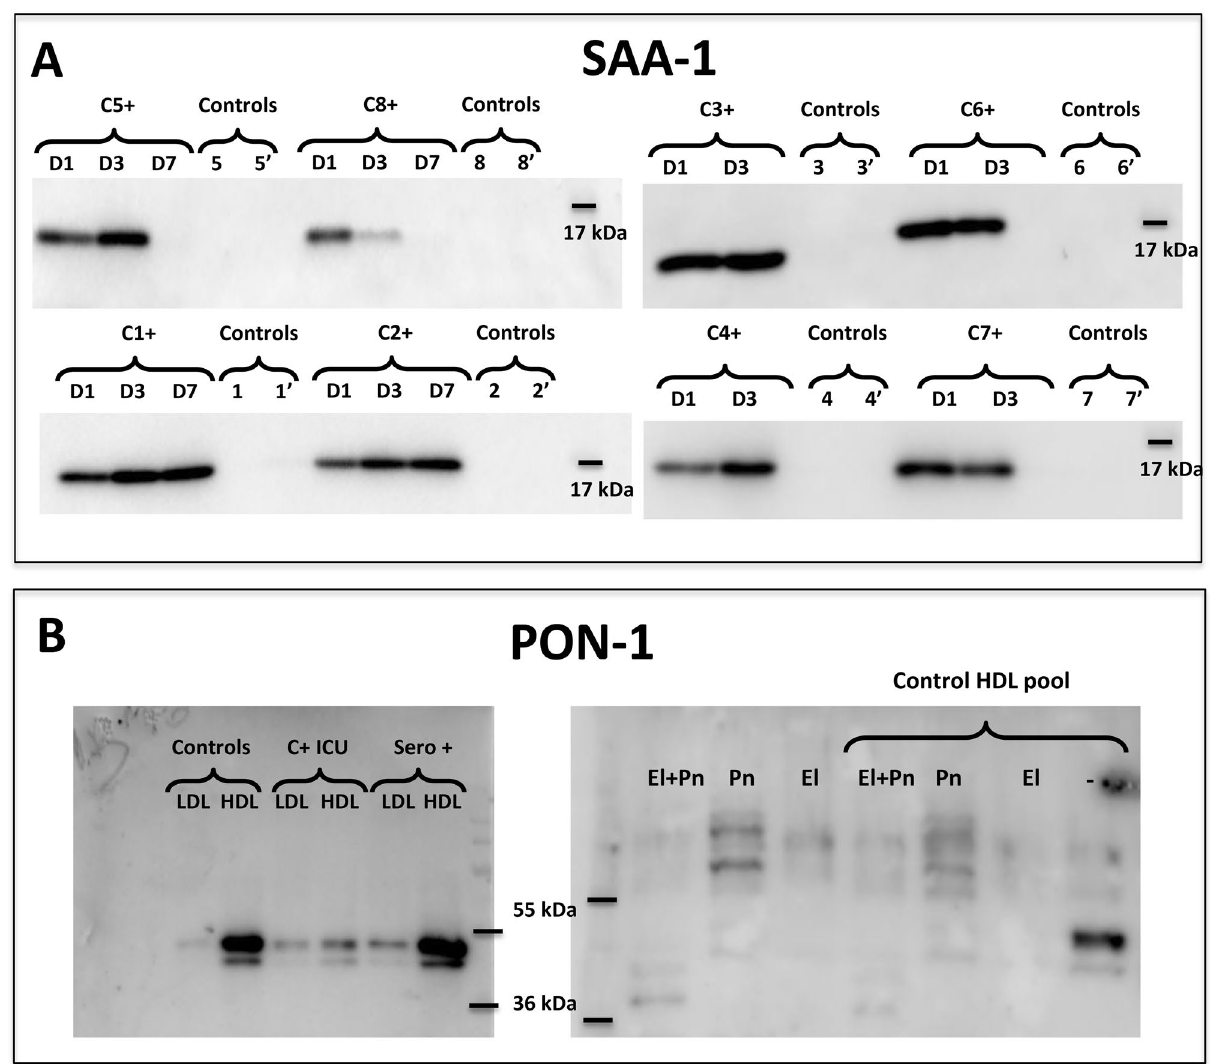
Figure 3. Western blot analysis for detection of SAA and PON-1 in HDL isolated from COVID-19 patients and controls. HDLs (3 μg protein /lane) were immunoblotted for SAA (serum amyloid A) ( A ) and PON-1 (paraoxonase 1) ( B ). ( A ) HDLs isolated from patients and controls are presented individually (C1+ = ICU- COVID-19 positive patient #1, C2+ for patient #2, etc.) at day 1, 3 and 7 after admission (D1, 3 and 7). Controls 1 and 1 ′ correspond to HDLs isolated from healthy subjects sex- and age-matched to patient #1. ( B ) Pools of LDLs and HDLs were blotted for PON-1 (left panel) after isolation from non-infected healthy subjects ("Controls"), COVID-19 positive patients in intensive care unit ("C+ICU") (n = 8) and SARS-CoV-2 seropositive cured caregivers ("sero+", sampled > 15 days after symptoms, n = 7). A pool of control HDLs containing PON-1 was incubated with elastase (El, 20 μg/mL), plasmin (Pn, 500 μg/mL) or both proteases (El + Pn) for 2 h at 37 °C. Enzymes alone (without HDLs) treated in the same experimental conditions were loaded as control. Uncropped gels are presented in Supplementary information were increased (SAA, CRP, etc.) relative to control subjects 35 . In the present study, we aimed at characterizing HDL protein composition and endothelial protective effect by a mass-spectrometry-based proteomic approach in COVID-19 patients. HDL fraction was isolated by ultracentrifugation, starting form a small volume of plasma (400 μL). Although this method is the gold standard for lipoprotein isolation, some proteins may be lost during the two steps of ultracentrifugation, and the sensitivity for proteomic identification may be insufficient to discover low-abundance proteins, due to the small amount of plasma initially available. However, under these conditions, we identified 83 proteins associated with HDLs. Among these proteins, most of the expected apolipoproteins associated with HDL were decreased, including ApoA-II, ApoC-I, II, III, IV, ApoA-IV, ApoC-I, ApoJ, Apo(a), ApoE, ApoM, ApoD, ApoB100 and ApoF. In addition, other proteins including beta2-glycoprotein 1, CD44 antigen and serum paraoxonases 1 and 3 were also less abundant in HDLs from COVID-19 patients. Paraoxonase 1 plays an important role in antioxidant HDL functions and was shown to be decreased in septic patients 36,37 . Here, we show that PON-1 is less abundant on HDL particles isolated from COVID-19 patients. We tested the